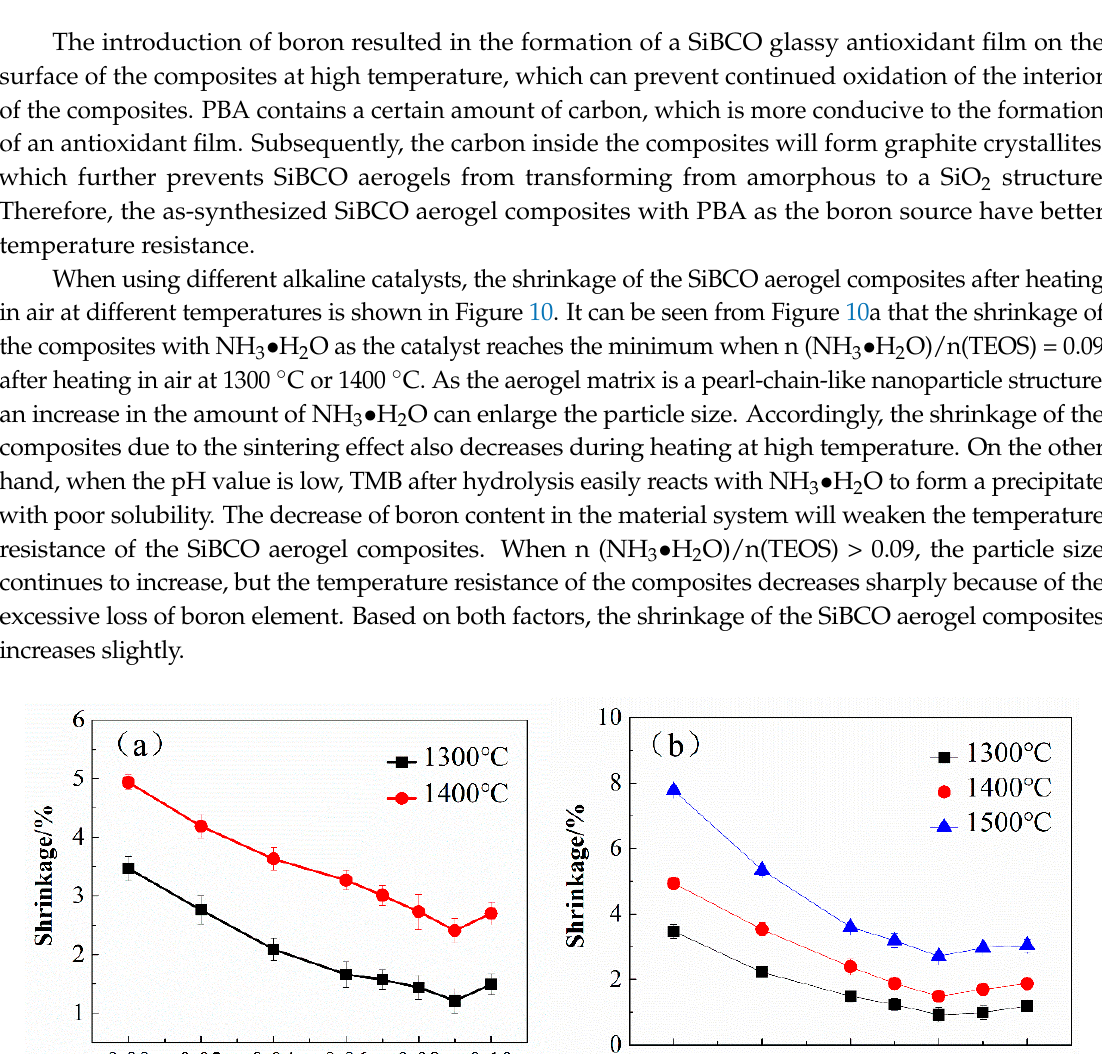
Figure 10. The shrinkage of the SiBCO aerogel composites with varying contents of NH 3 • H 2 O ( a ) and EN ( b ) after heating in air at different temperatures.